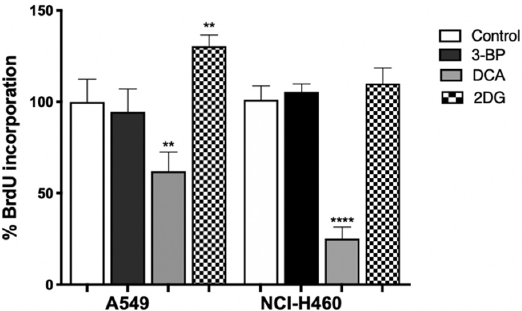
Figure 5. Effect of GIs on cell proliferation of lung cancer cells. The cell lines were treated with the respective IC 50 of 3BP and DCA for 24 h and with 2DG for 48 h. Cell proliferation was assessed through the percentage of BrdU incorporated into the DNA of the treated cells. Results represent the mean ± SEM of a least three independent experiments, each one in triplicate. ** p < 0.01; **** p < 0.0001 compared to untreated cells (control).